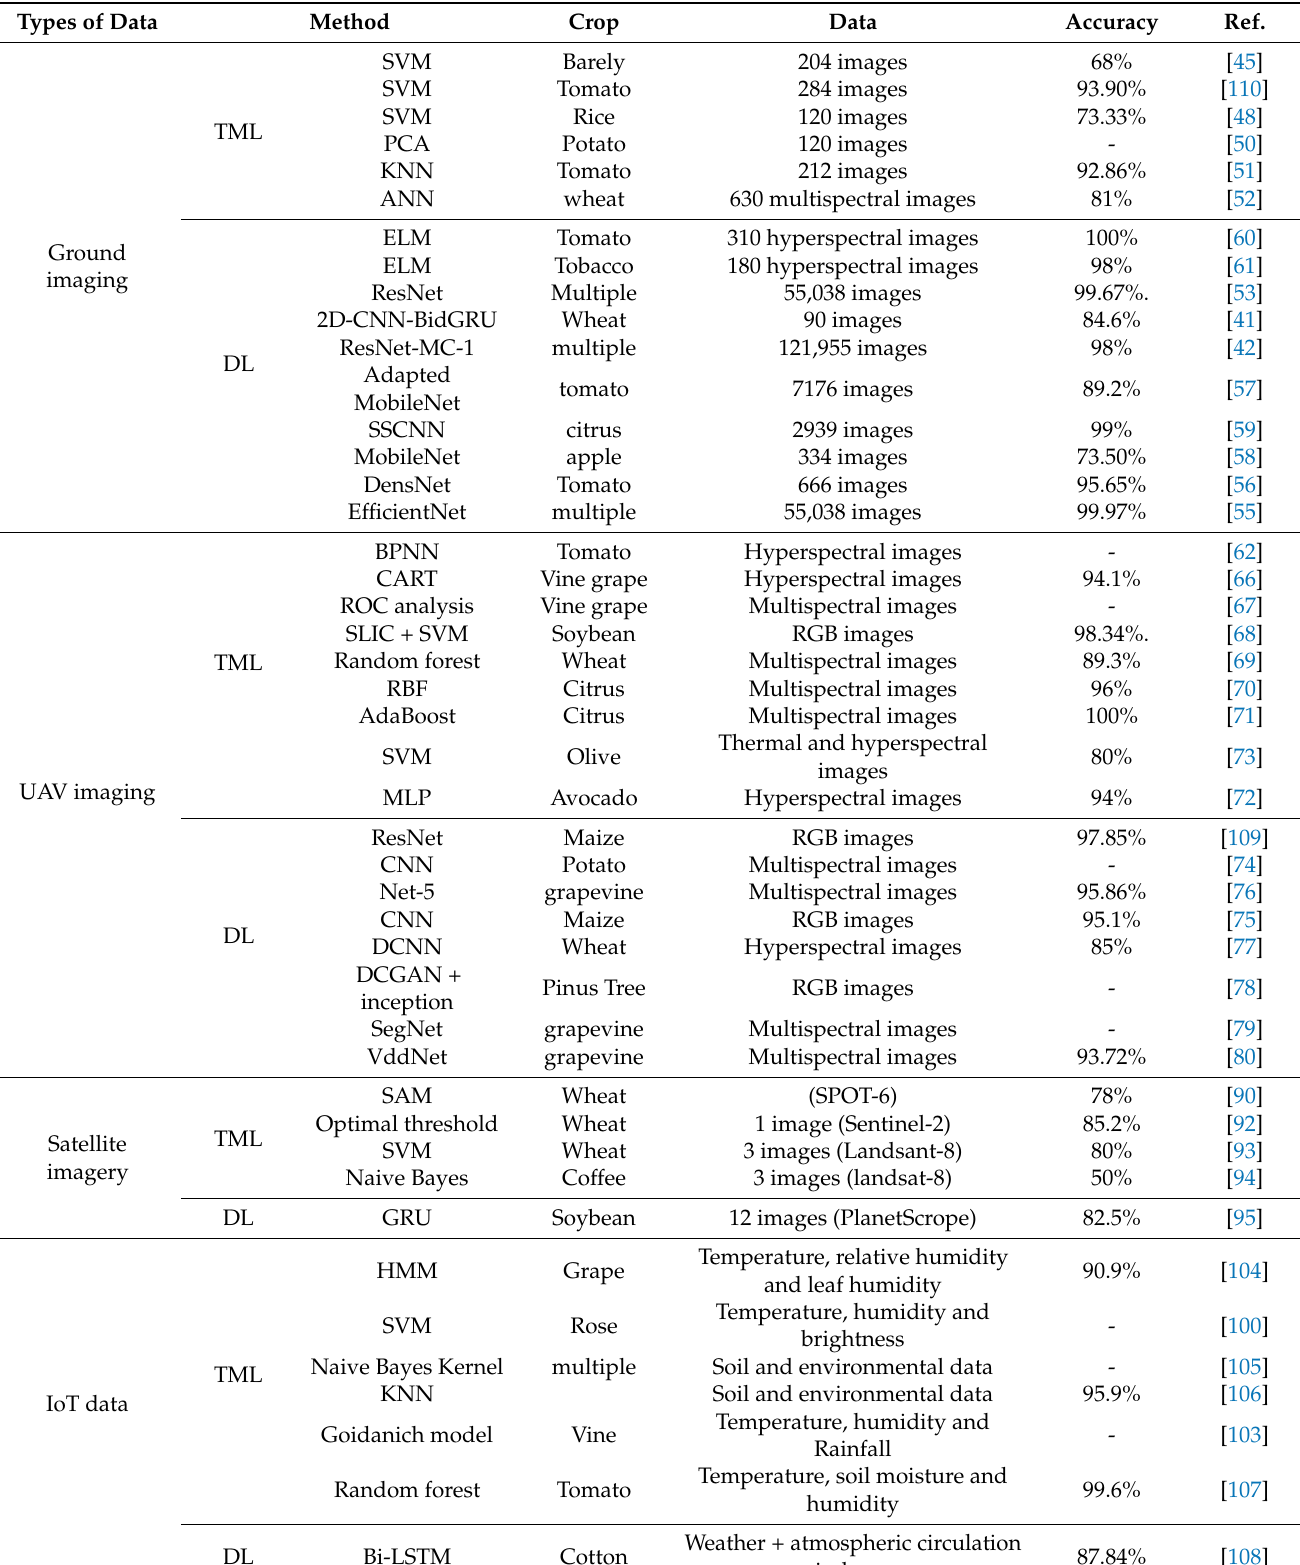
Table 5. Summary of various crop disease detection using imaging techniques, IoT and data fusion techniques, based on traditional machine learning (TML) and deep learning (DL)